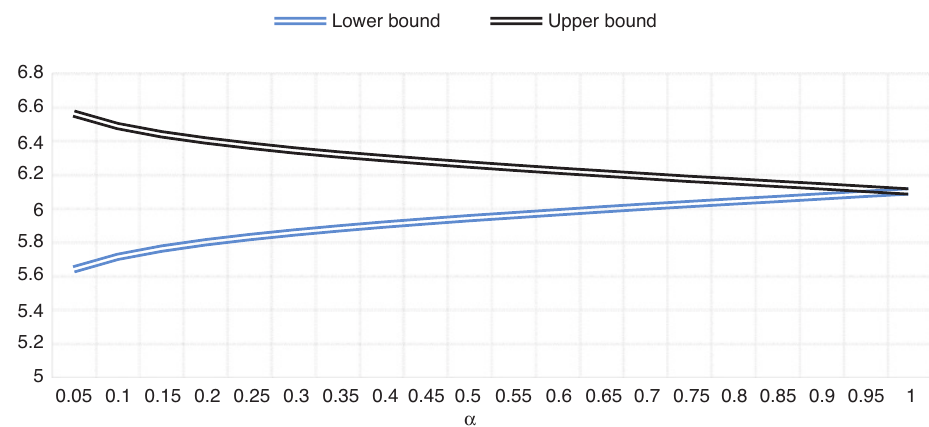
Figure 1: Confidence Intervals of Differences in Infinite Population